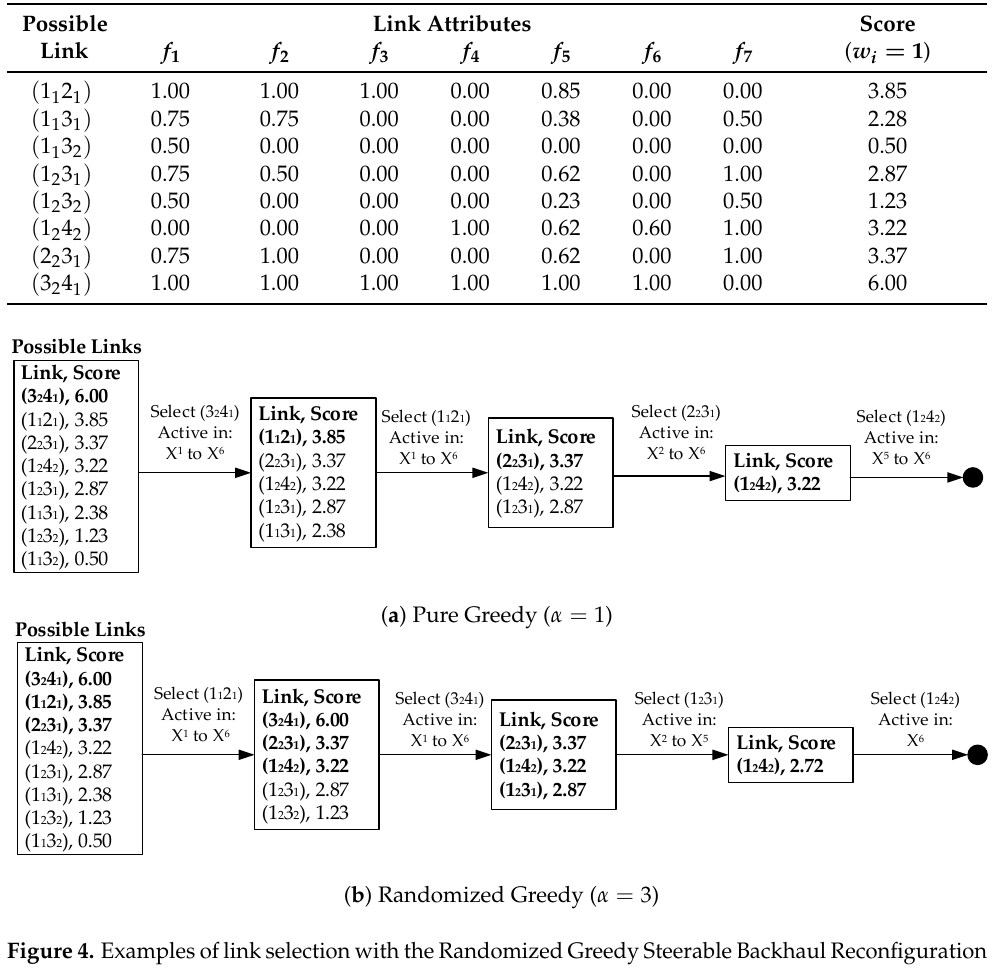
Figure 4. Examples of link selection with the Randomized Greedy Steerable Backhaul Reconfiguration Algorithm (RG-SBRA)